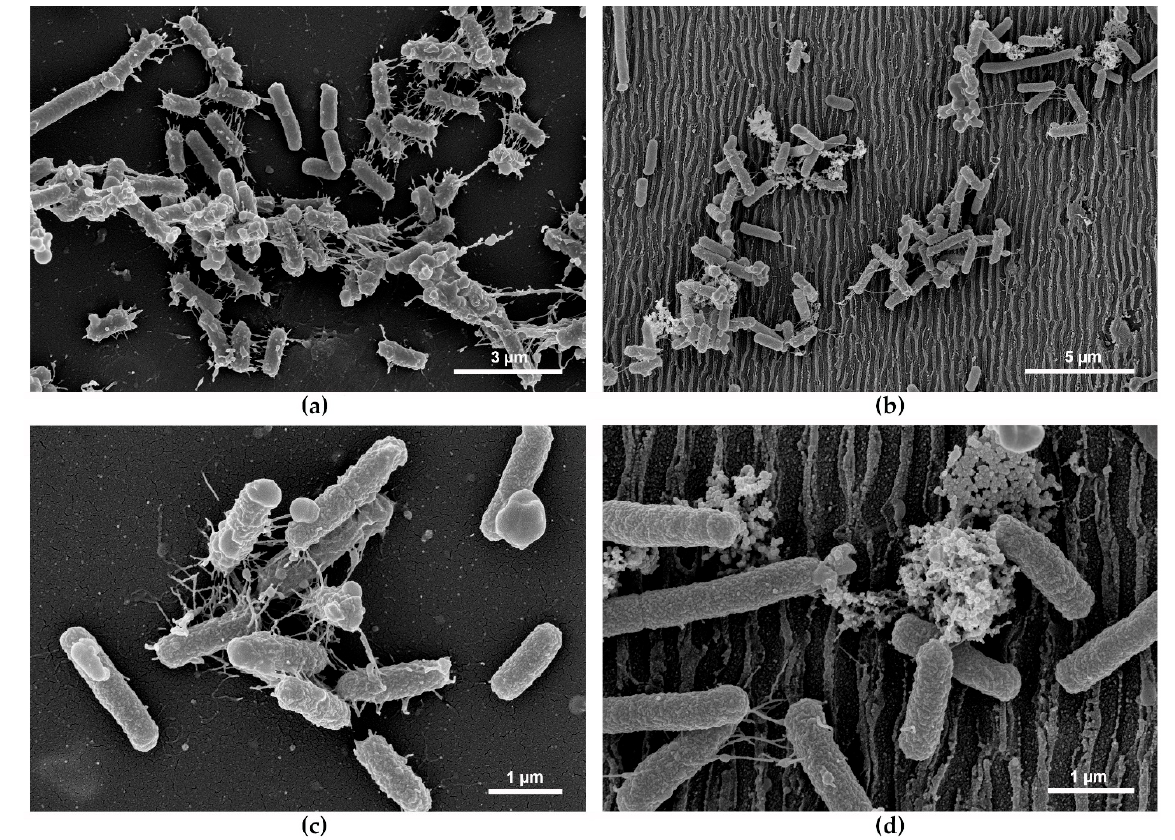
Figure 7. Top-view SEM micrographs of E. coli TG1 on ( a , c ) non-irradiated PET and ( b , d ) laser-structured PET with 214 nm LIPSS spatial period. Arrows in ( c , d ) indicate nanofiber-like cell appendages and extracellular matrix, respectively. Note the different scale bars.